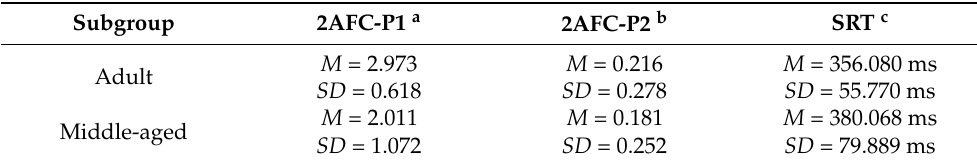
Figure 15. Linear regression for participants’ simple reaction time and elapsed time of diagnosis. Red line—linear regression for Mild-Moderate post-COVID group (LR for MM); blue line—linear regression for Severe-Critical post-COVID group (LR for SC); RT MM , Mild-Moderate group’s reaction time; RT SC , Severe-Critical group’s reaction time; m MM , Mild-Moderate group’s slope; m SC , Severe-Critical group’s slope. Table 8. Severe-critical group statistics by age